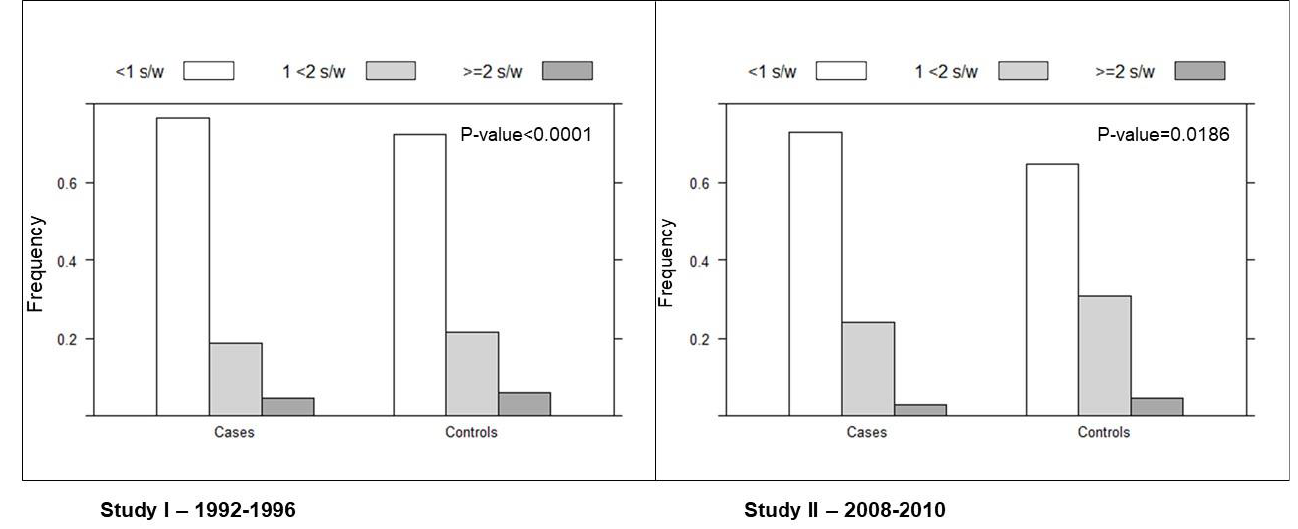
Figure 1. Distribution of canned fish consumption in cases and controls in the two studies.